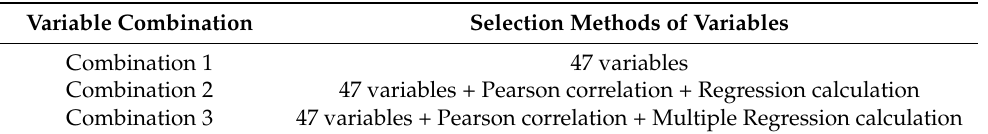
Table 3. Explanation of variable